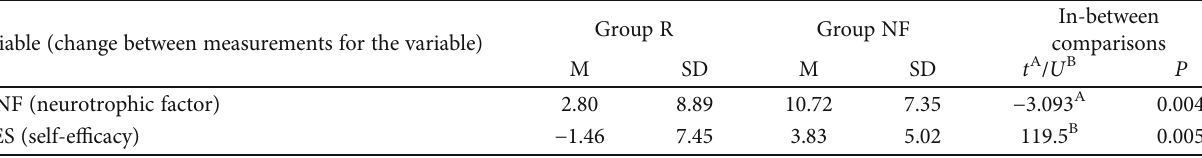
Table 2: Primary outcomes: statistically signi fi cant di ff erences between groups R and NF in the magnitude of change from pre- to posttherapy outcomes.